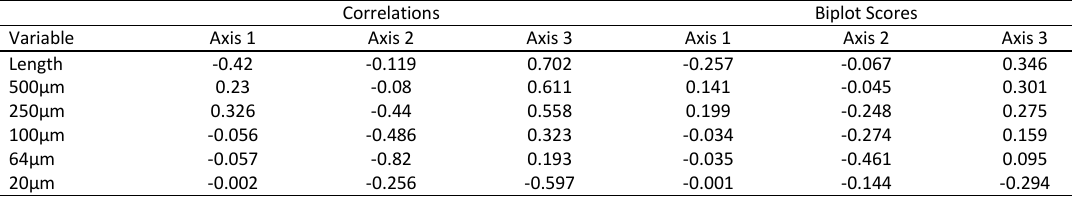
Table 3: Pairwise correlation matrix among the explanatory variables